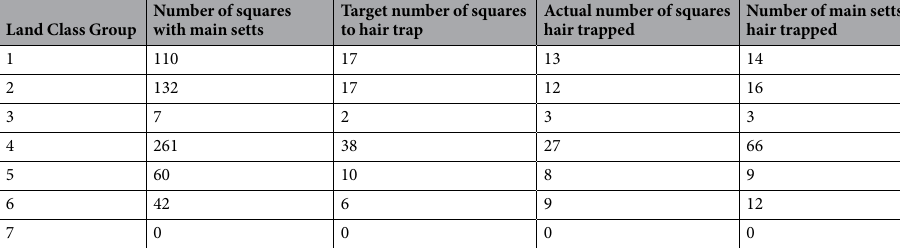
Table 4. Land Class Groups showing the associated total number of squares with main setts recorded in the 2011–13 badger sett survey of England and Wales 9 and the numbers of squares and main setts that were hair- trapped to estimate social group size in the present study. As no main setts were recorded in Land Class Group 7 in the 2011–13 badger sett survey, it was not possible to deploy any hair traps in this